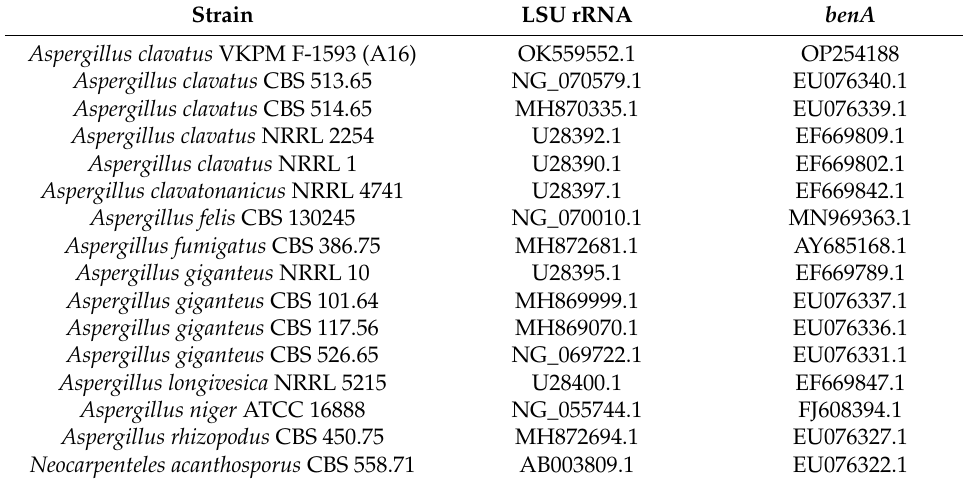
Table 2. NCBI accession numbers for the sequences used for phylogenetic